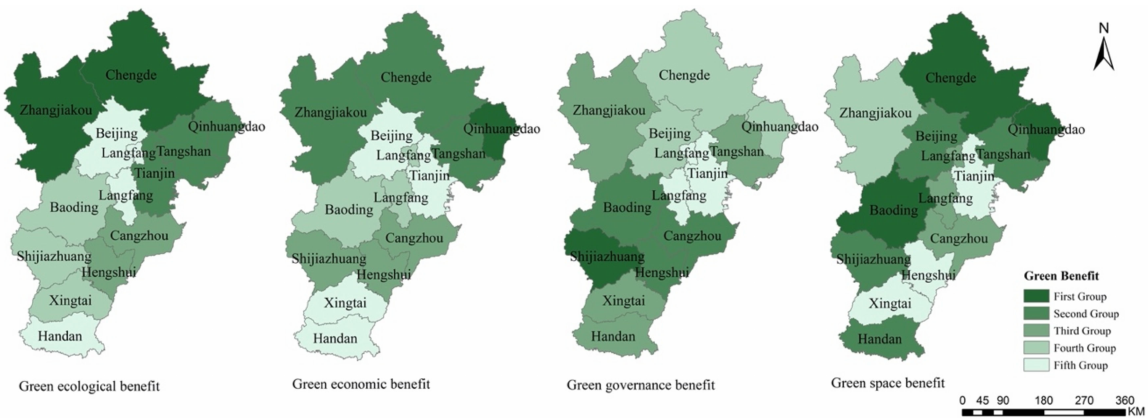
Figure 3. Spatial pattern of Beijing–Tianjin–Hebei land use green benefit